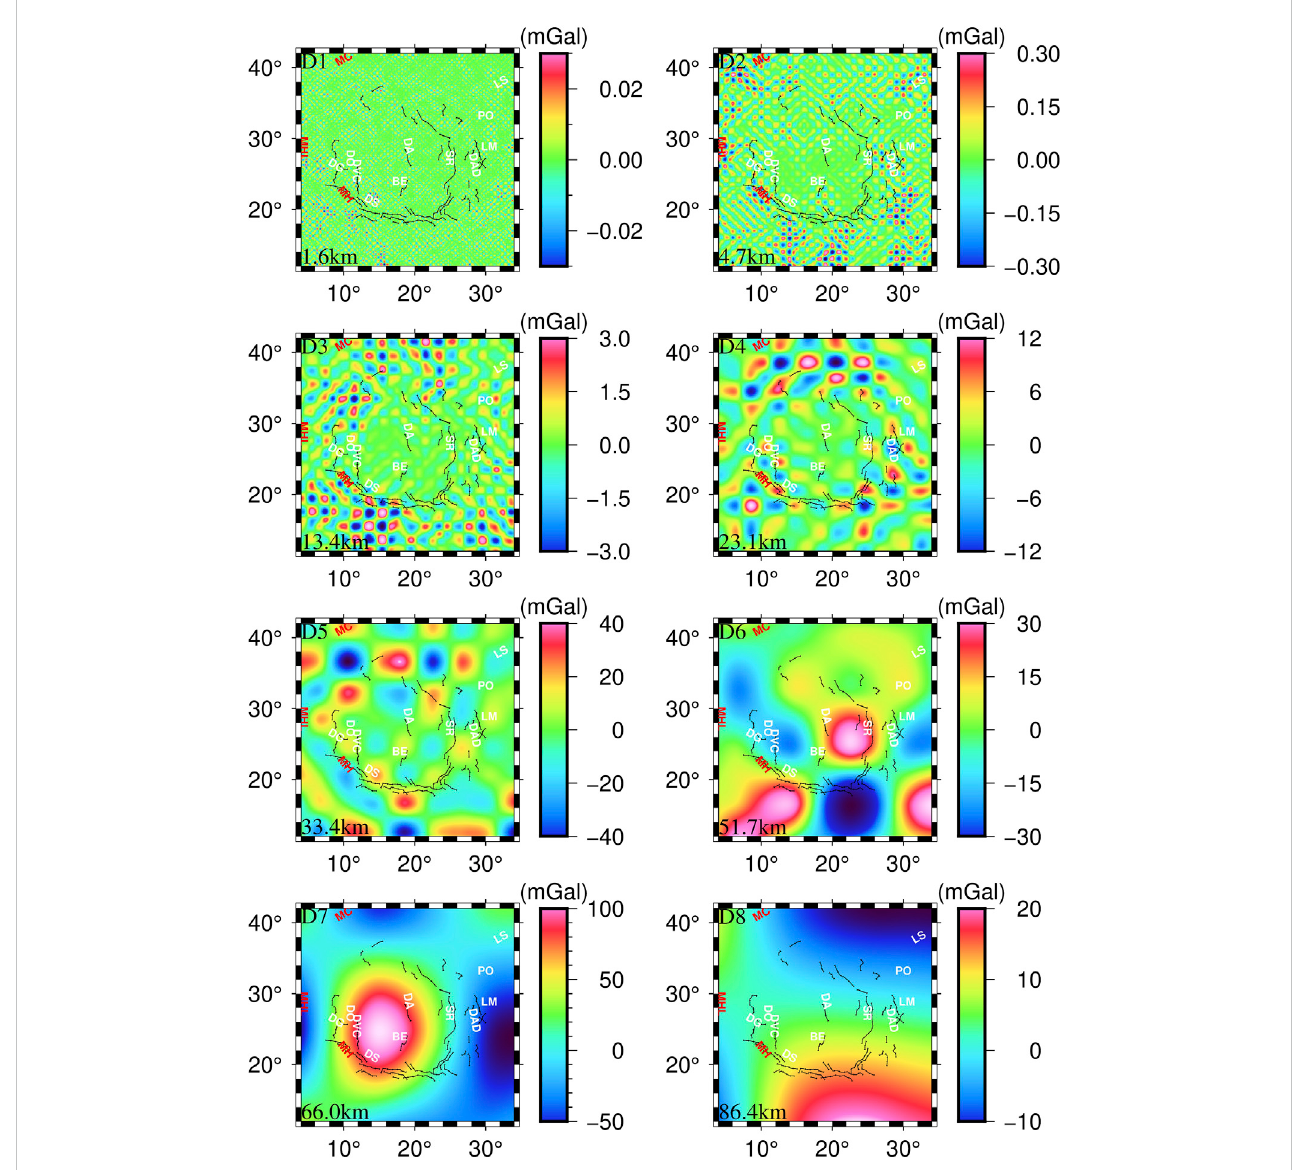
FIGURE 3 Decomposed gravity anomalies D1 – D8 in the Mare Serenitatis, whose mean fi eld source depths estimated by Eq. 3 have marked on the left bottom of each fi